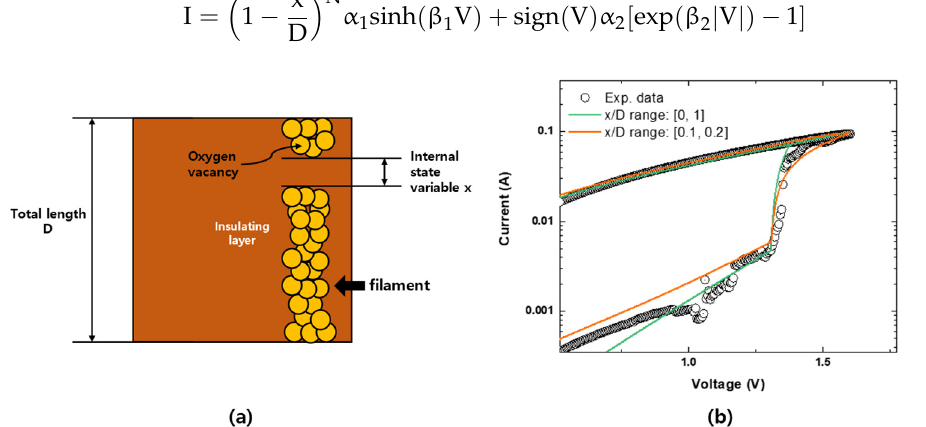
Figure 2. ( a ) Schematic of the rearranged internal state variable x, ( b ) Electrical characteristics of the improved model with reflecting property of the Pt/Ti/TiOx/Al2O3/Pt/Ti device. Equation (4) pertains to the switching region, where the set and reset processes occur.